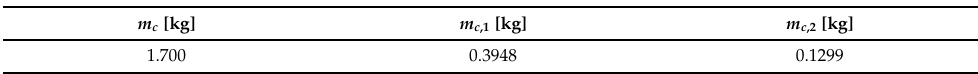
Table 5. Balancing masses for a 4 cylinder